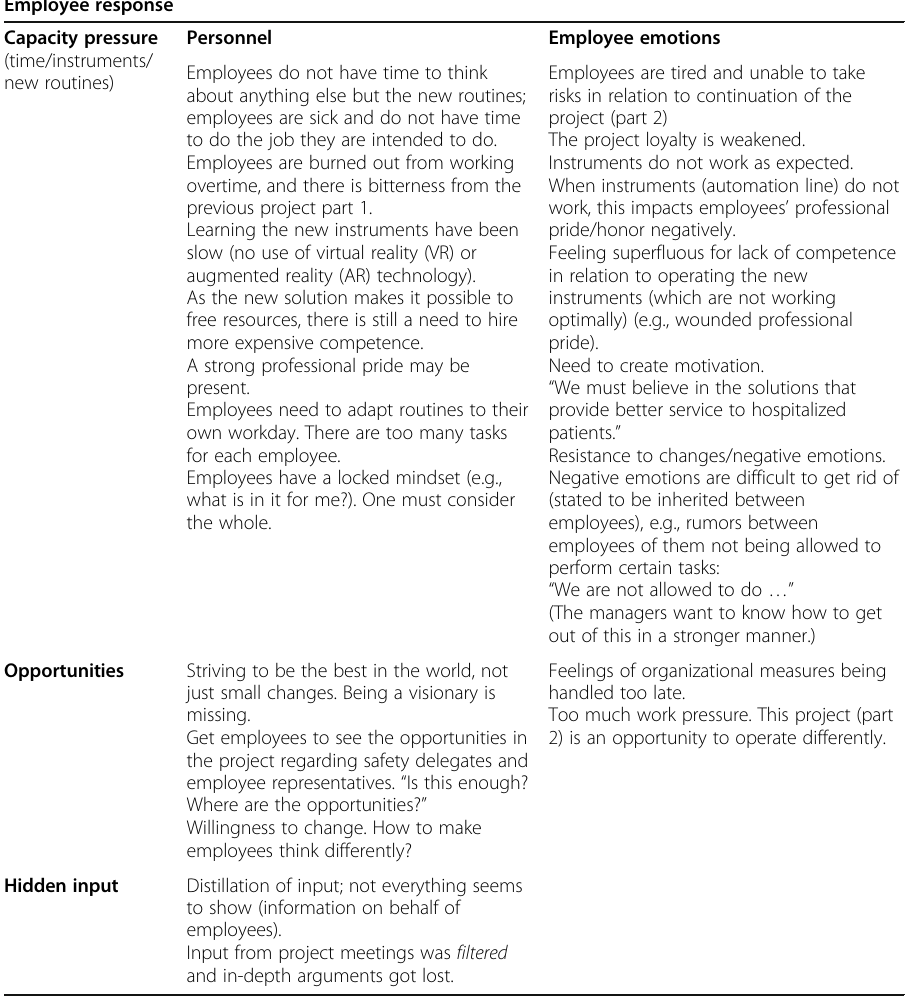
Table 2 Issues communicated at the workshop on behalf of the cluster ’ s “ personnel and employee emotions